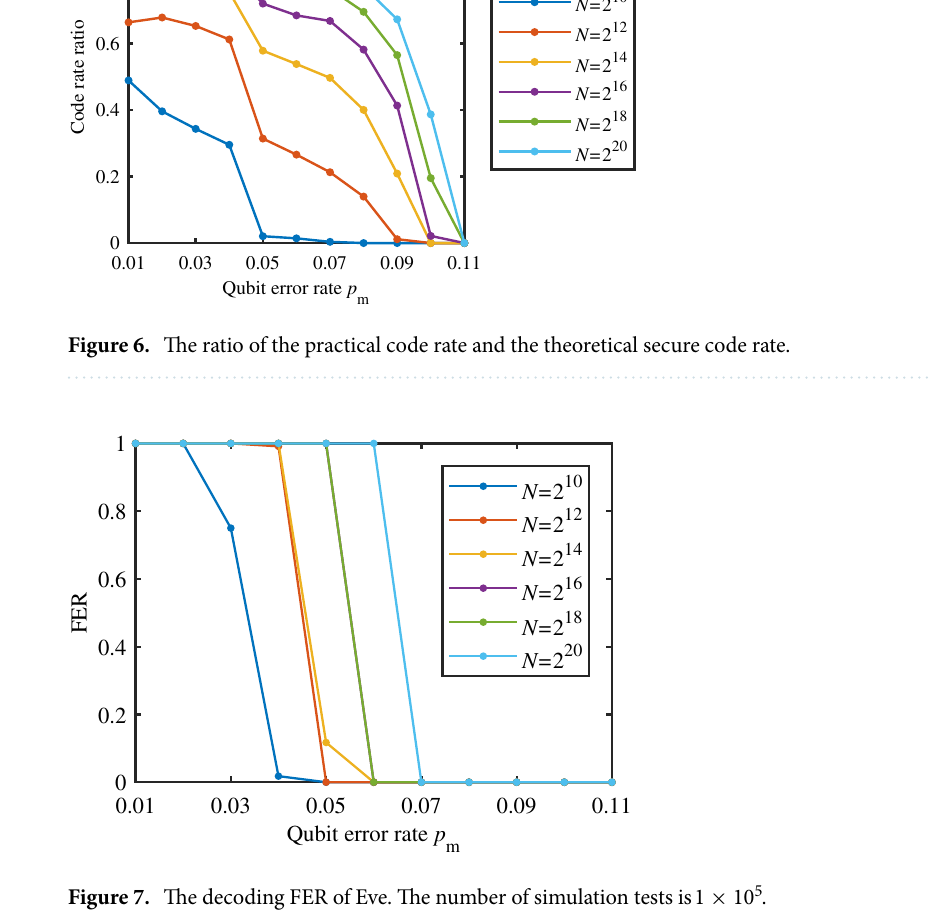
Figure 7. The decoding FER of Eve. The number of simulation tests is 1 × 10